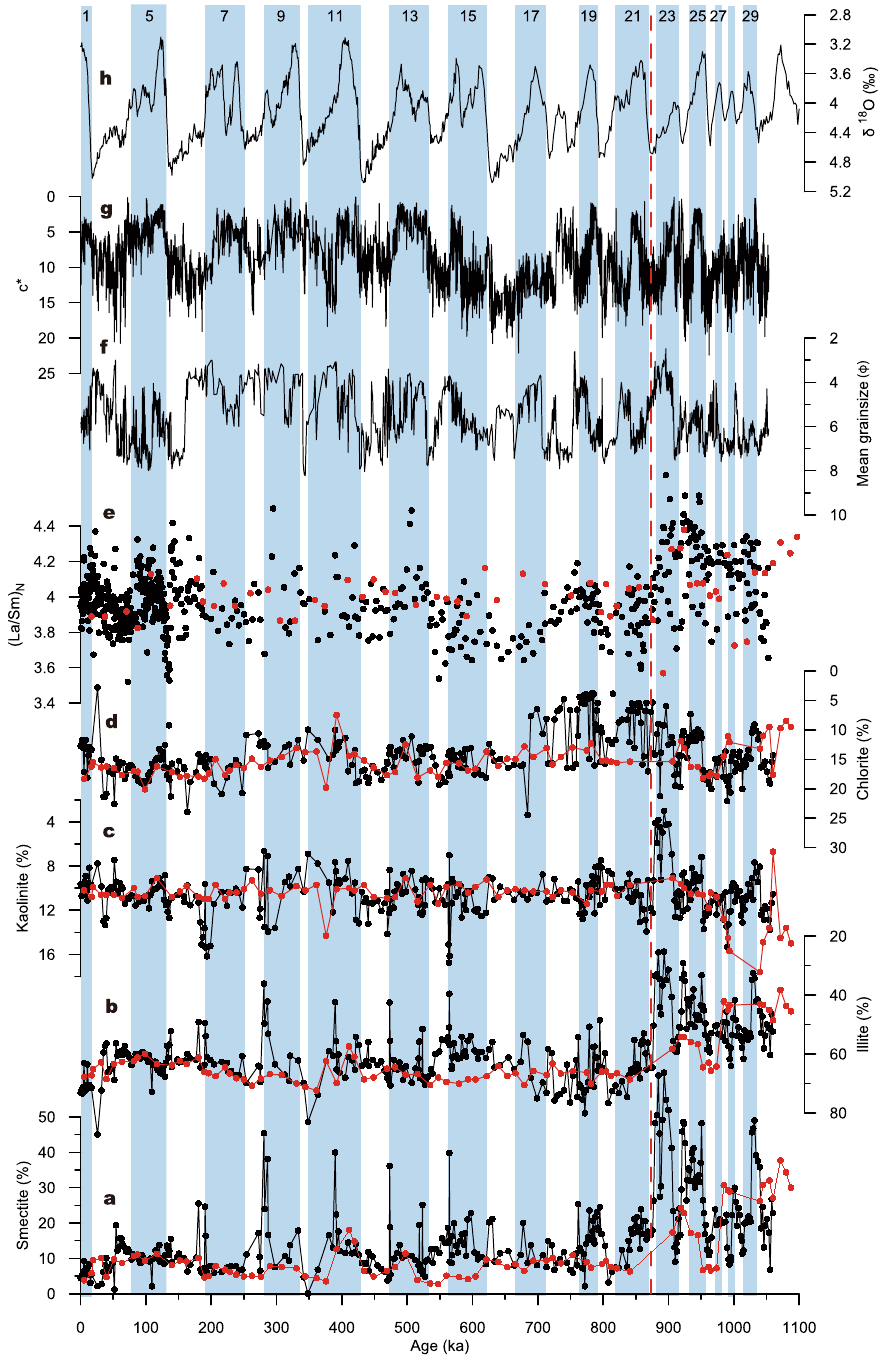
Figure 3. Temporal variations of clay minerals and La/Sm ratio in cores BH08 (black dots) and NHH01 (red dots) compared with marine oxygen isotope record (LR04). ( a ) Smectite. ( b ) Illite. ( c ) Kaolinite. ( d ) Chlorite. ( e ) Chondrite-normalized La/Sm ratio. ( f ) Mean grainsize. ( g ) Sediment color reflectance (c * , an indicator of transgression-regression cycles) 18 of core BH08. ( h ) Stacked marine oxygen isotope record (LR04) 68 . The vertical shaded areas labeled with odd numbers represent the interglacial periods. The vertical dashed line denotes the age boundary of ~880